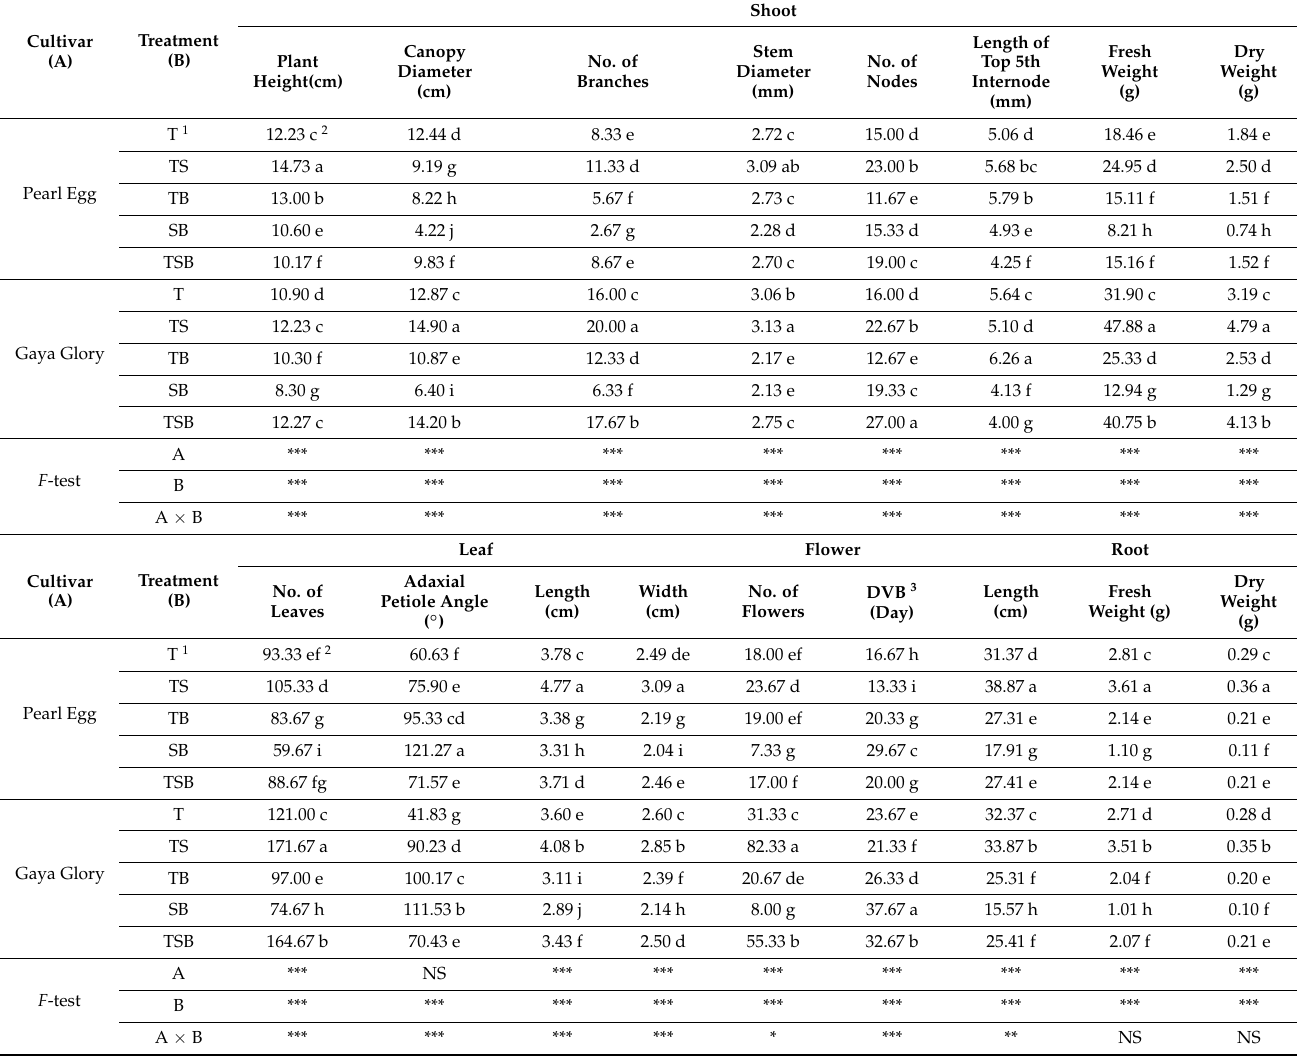
Table 1. The influence of the lighting direction combinations on the growth and development of chrysanthemums grown for 45